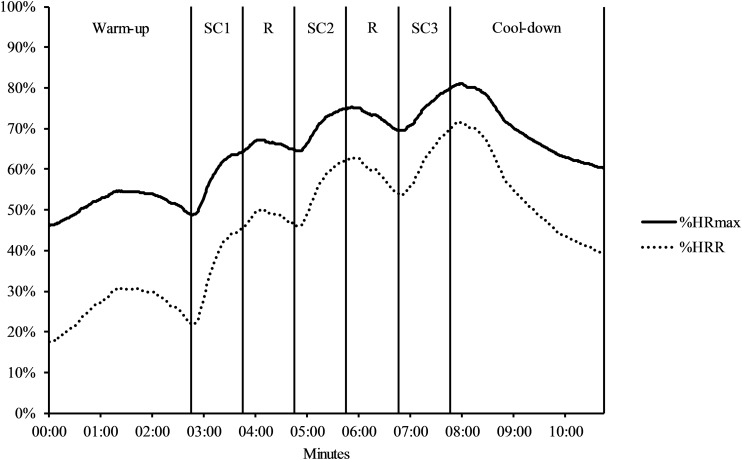
Mean %HRmax and %HRR during the stair-climbing protocol. SC, stair-climbing interval; R, recovery; HRmax, heart rate maximum; HRR, heart rate reserve.